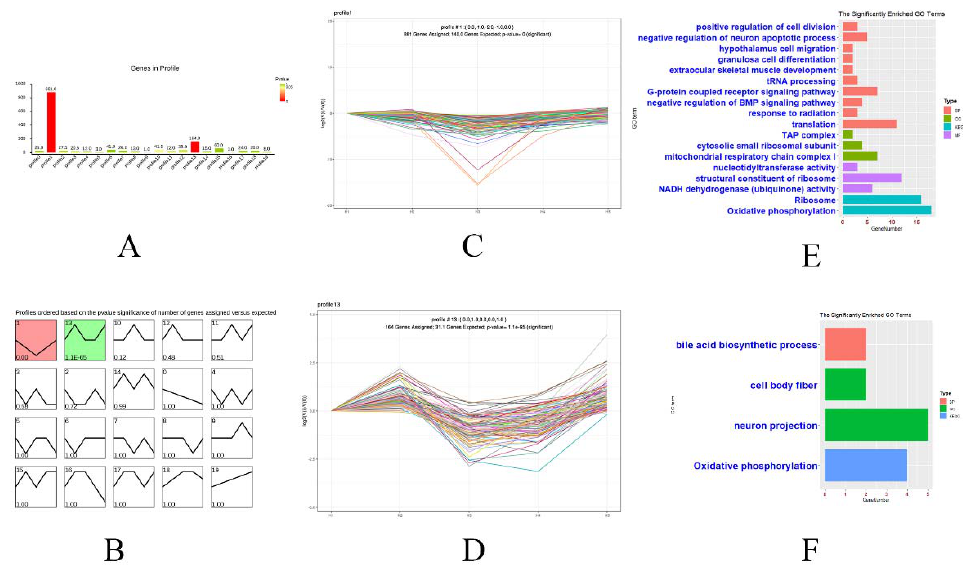
Figure 4. All the DEGs in the hypothalamus and ovary of the 3 groups were analyzed by Short Time-Series Expression Miner (STEM). STEM clustering of the numbers of DEGs at 19 profiles in the hypothalamus ( A ). The number on the top right corner represents the cardinality of each cluster, and the number on the bottom left represents the adjusted p -value; all significant profiles based on p values of the numbers of genes ( B ). Expression patterns of profiles 1 ( C ) and 13 ( D ). GO analysis (BP, CC, and MF) and KEGG pathways of genes clustered in profiles 1 ( E ) and 13 ( F ).